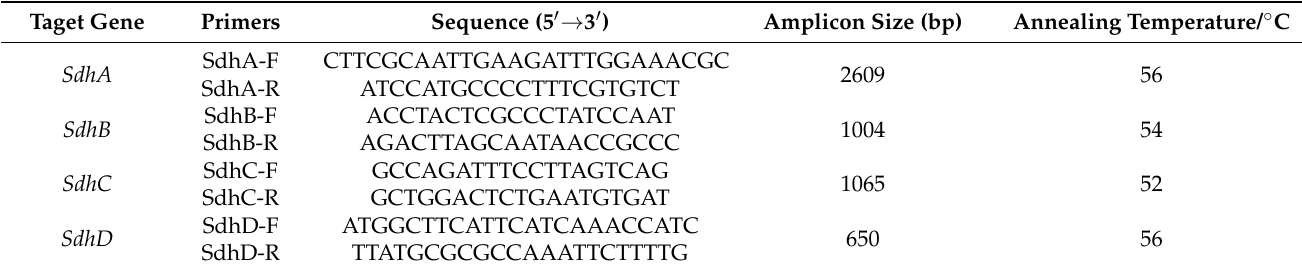
Table 1. Primers used for this study.